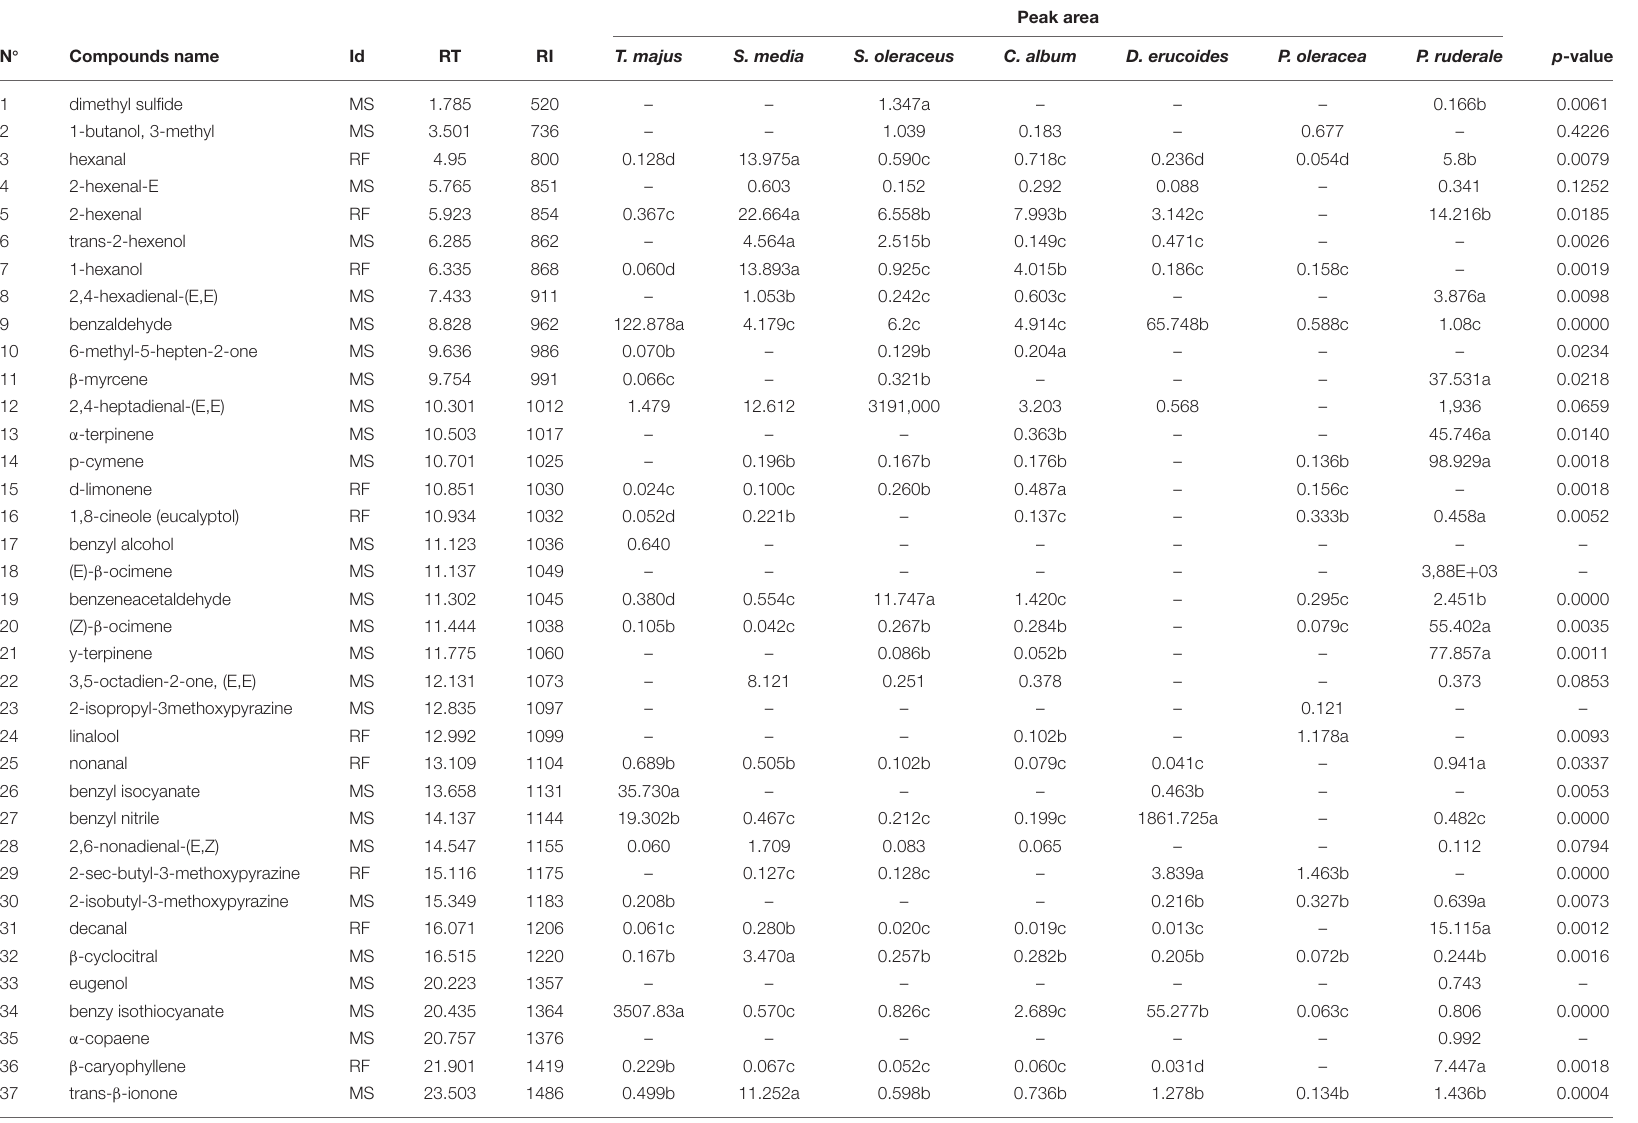
TABLE 1 | Mean values (GC-peak area unit x 10 6 ) for individual volatile compound identified in the leaves of the seven undervalued species and levels of significance ( p